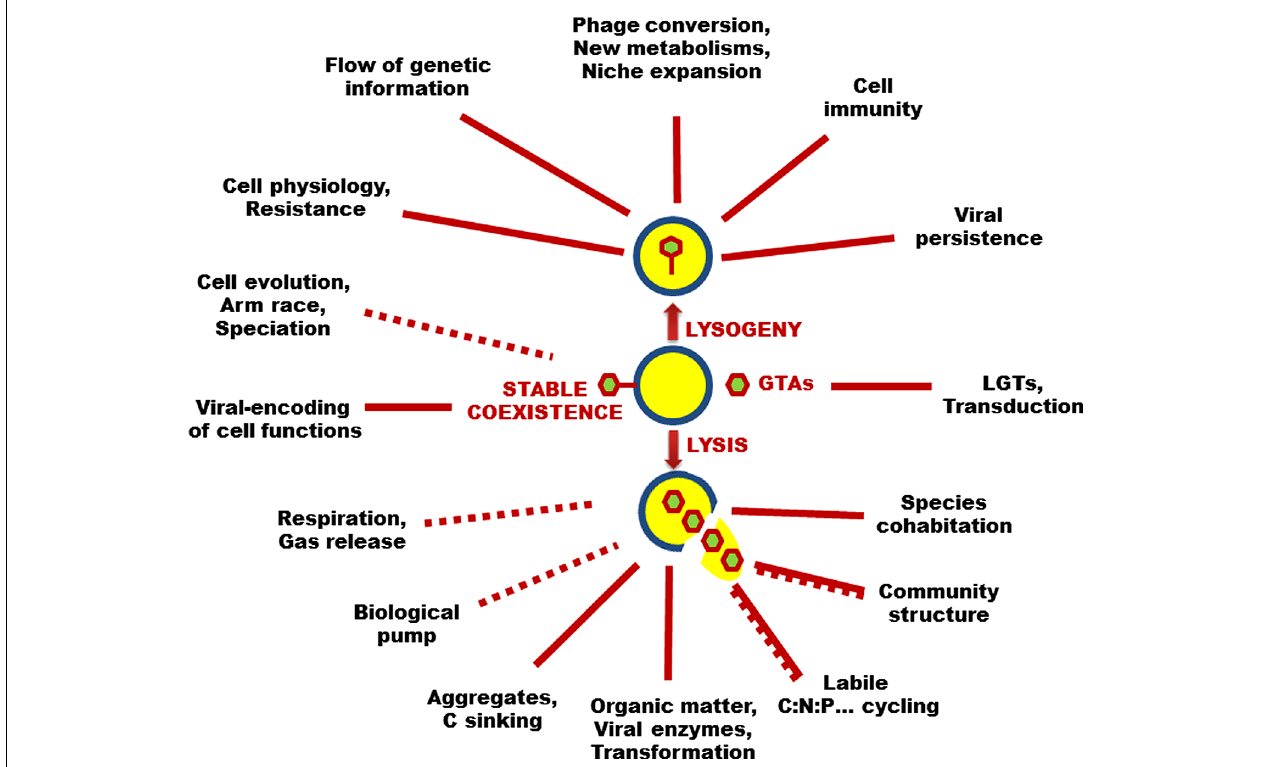
abundant, and ubiquitous biological entities in the biosphere where they have tremendous effects on the diversity of living things, the functioning of microbial ecosystems, and the evolution of the cellular world. Some of these direct (solid lines) and indirect (dashed lines) effects on aquatic microbial processes are highlighted in this figure. Please refer to the main text for